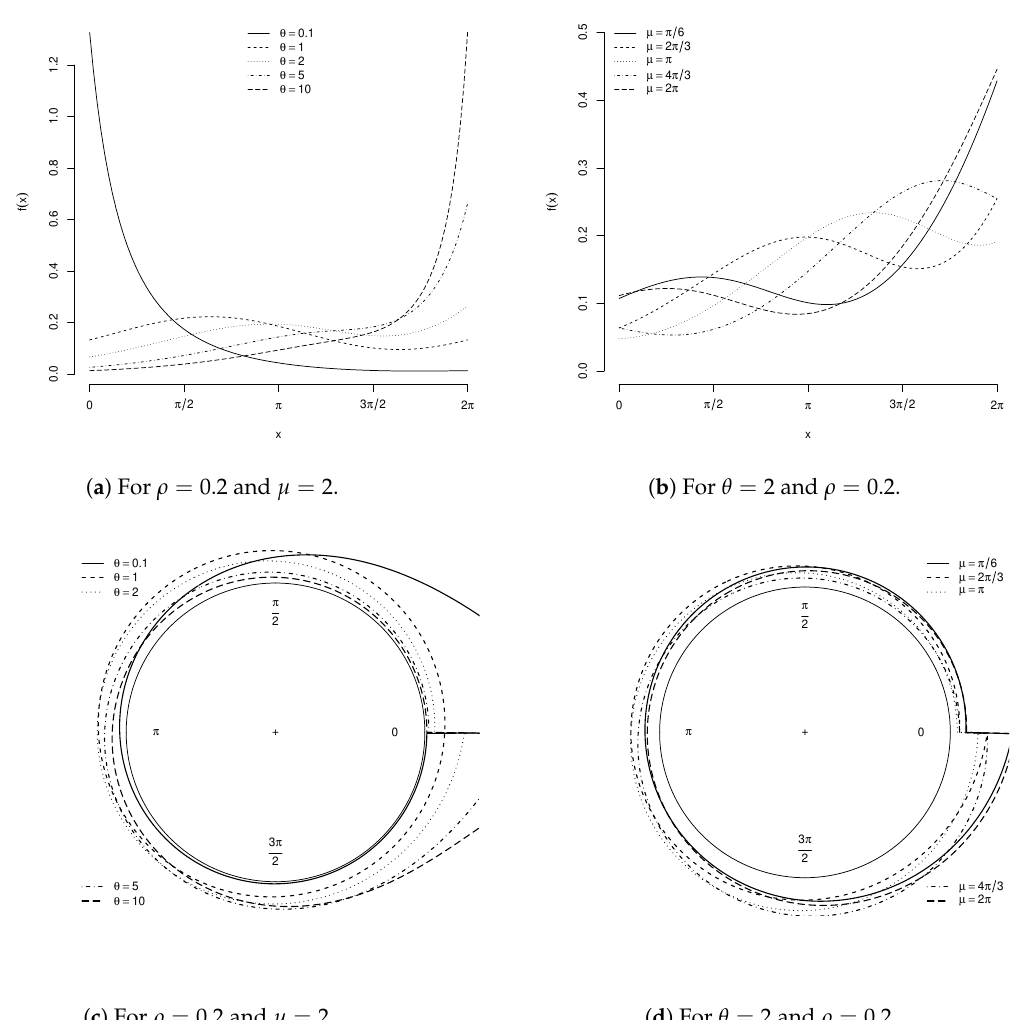
Figure 4. Cartesian and circular MOC densities for some parametric